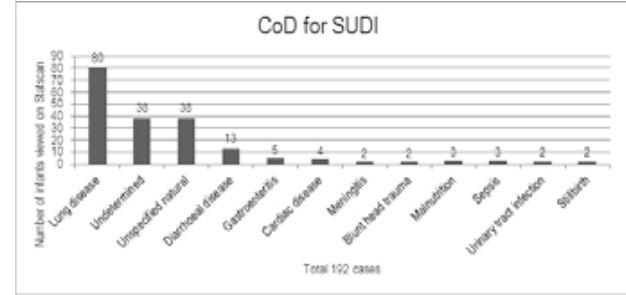
Fig. 1. Cause of death in 192 infant cases designated as SUDI on entering the forensics laboratory.